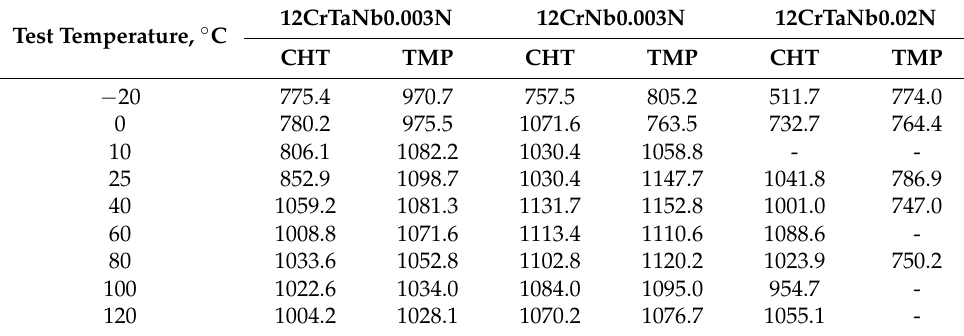
Table 4. The maximum stress (in MPa) for the different 12% Cr